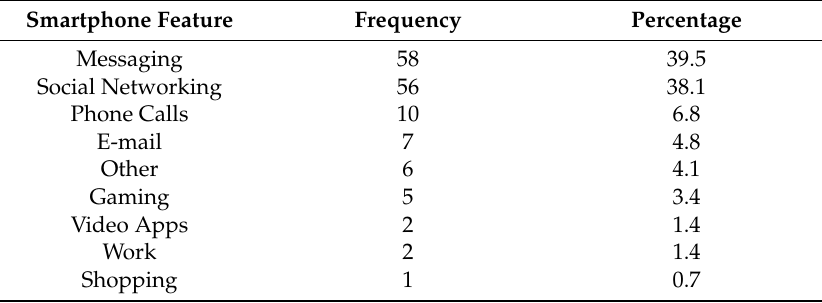
Table 2. Most frequently used smartphone features among